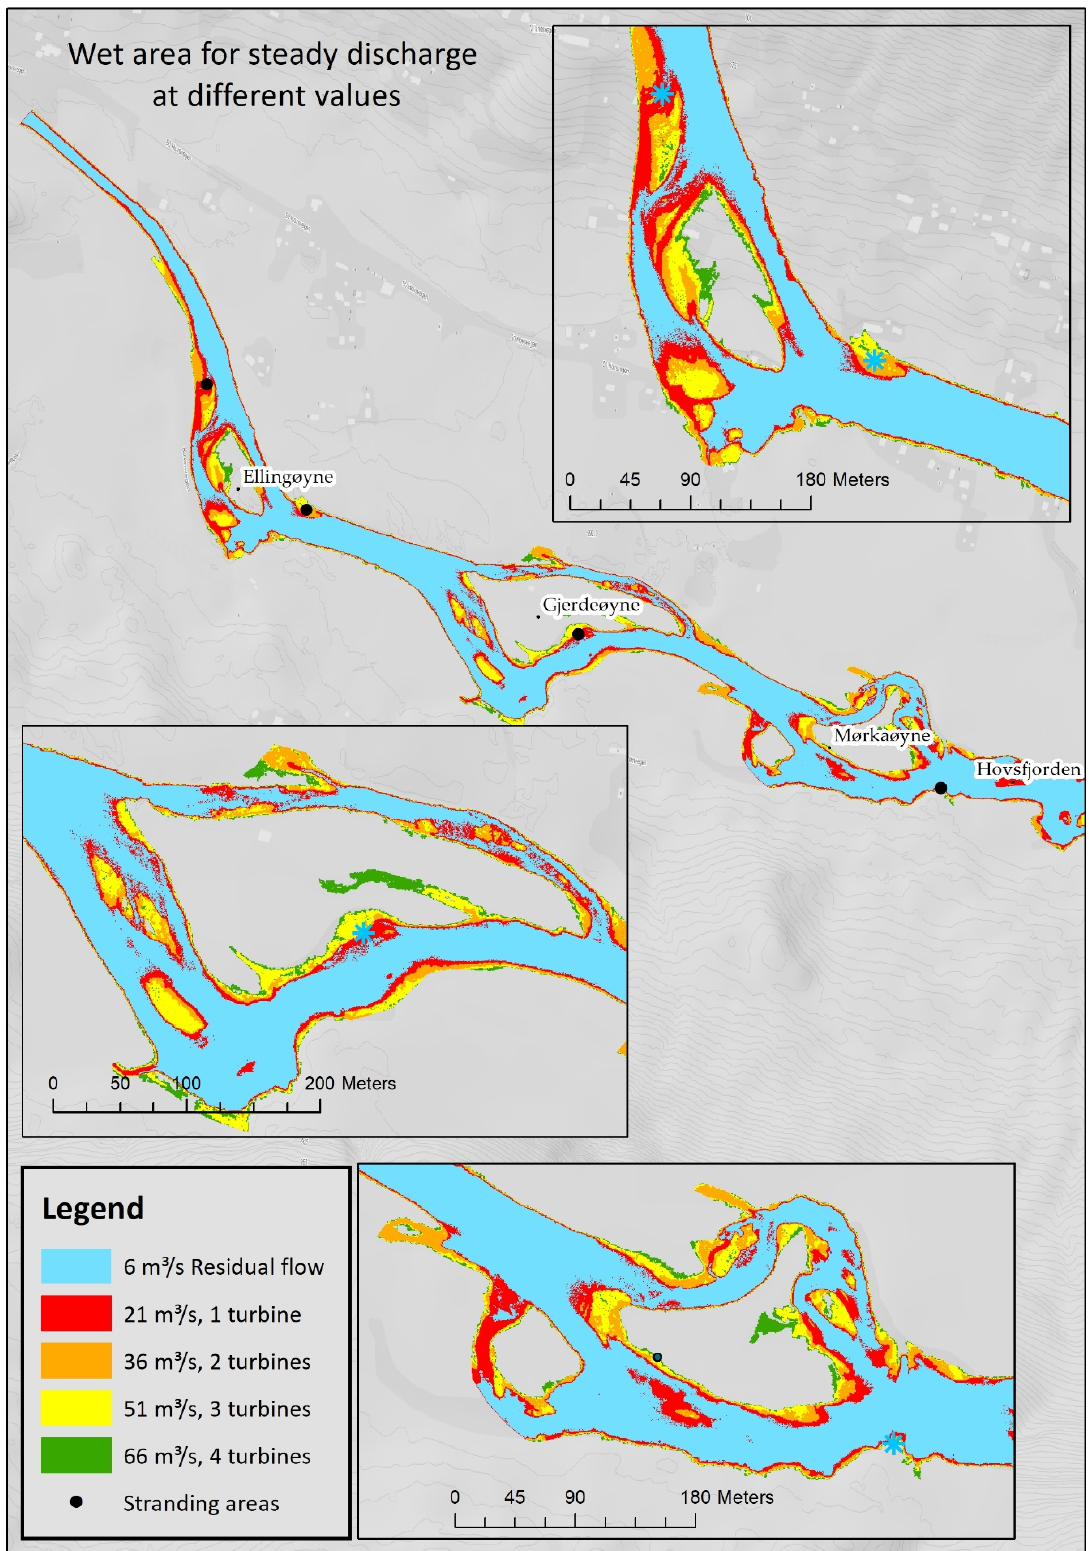
Figure 6. Wet area for steady discharge and different values: in blue the wet area at residual flow (6 m³/s); in red the wet area with one turbine running and residual flow (21 m³/s); in orange with two turbines running (36 m³/s); in yellow with three turbines (51 m³/s) and in green full production with four turbines running (66 m³/s).